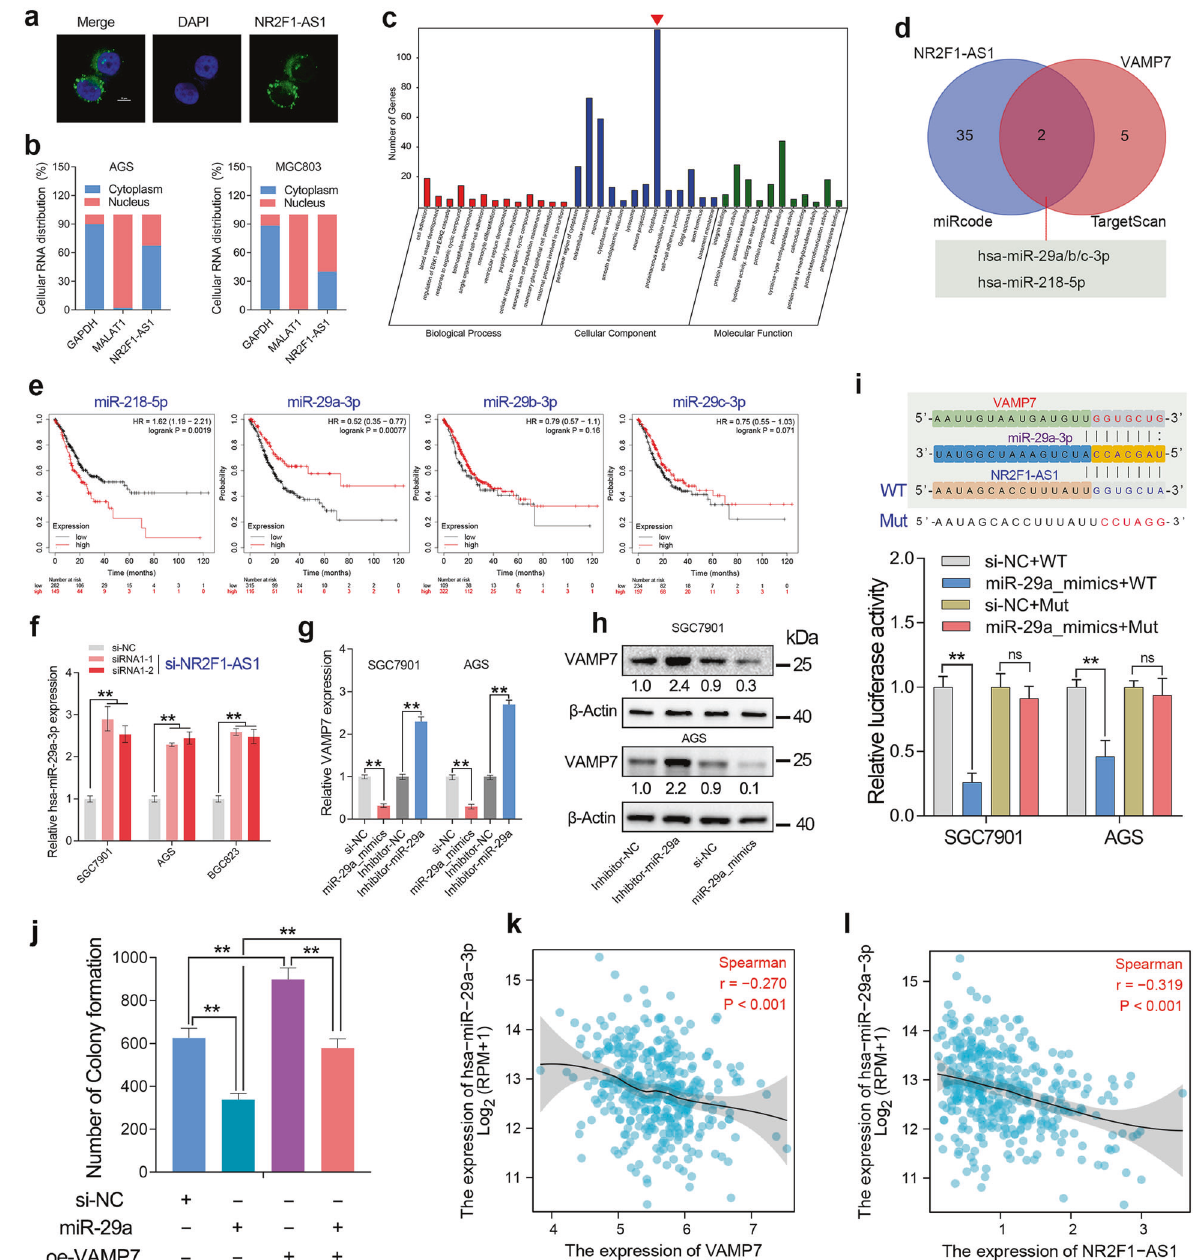
Fig. 7 NR2F1-AS1 acted as a sponge of miR-29a-3p to regulate VAMP7 expression. a The subcellular distribution of NR2F1-AS1 in SGC7901 cells. b NR2F1-AS1 transcripts were located in cytoplasm and nucleus of GC cells. c GO analysis con fi rmed NR2F1-AS1 knockdown mainly function in cytoplasm. d The miRNAs that sponged by NR2F1-AS1 and miRNAs that targeting VAMP7 were predicted by miRCode and TargetScan. e The survival analysis of miR-218-5p and miR-29a/b/c-3p in GC. f Knockdown of NR2F1-AS1 signi fi cantly upregulated miR-29a-3p expression in GC cell lines. g , h VAMP7 was negatively regulated by miR-29a-3p in GC cell lines. i Luciferase reporter assay con fi rmed that miR- 29a-3p can bind to NR2F1-AS1. j Rescue assay con fi rmed that miR-29a-3p inhibited the colony formation of GC cells by targeting VAMP7. k , l Both NR2F1-AS1 and VAMP7 showed a signi fi cant negative expression correlation with miR-29a-3p in the GC cohort from TCGA. ** P <